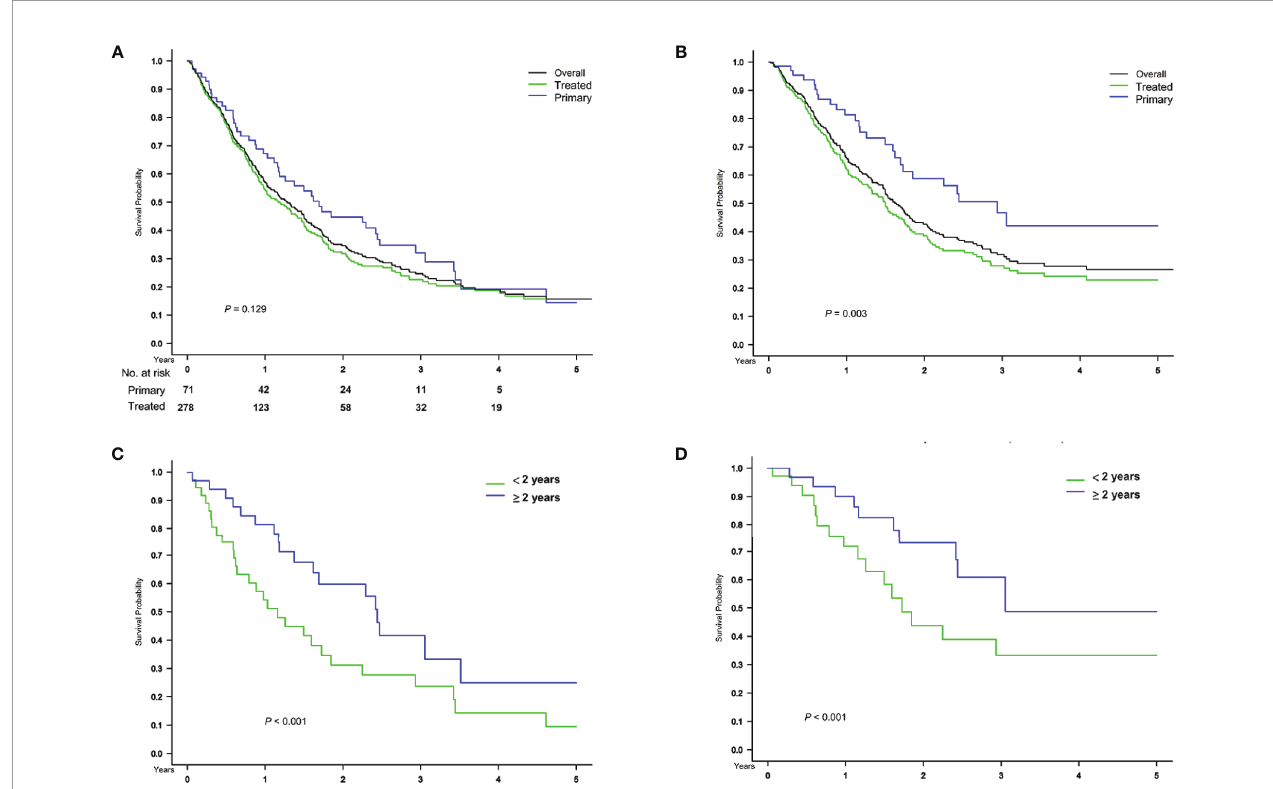
FIGURE 4 | Subgroup analysis in patients with primary HCC treated by upfront transplant. Comparison of (A) overall and (B) HCC-speci fi c survival after treatment for recurrence, strati fi ed based on primary and treated HCC before transplant surgery and on the timing of (C, D) recurrence in 71 patients with primary HCC treated by upfront